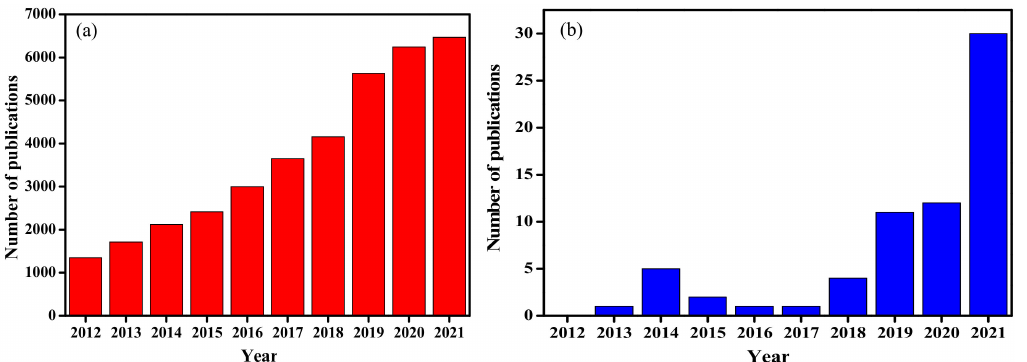
Figure 6. A schematic representation of the “top-down” and “bottom-up” approaches for the synthesis of CQDs.